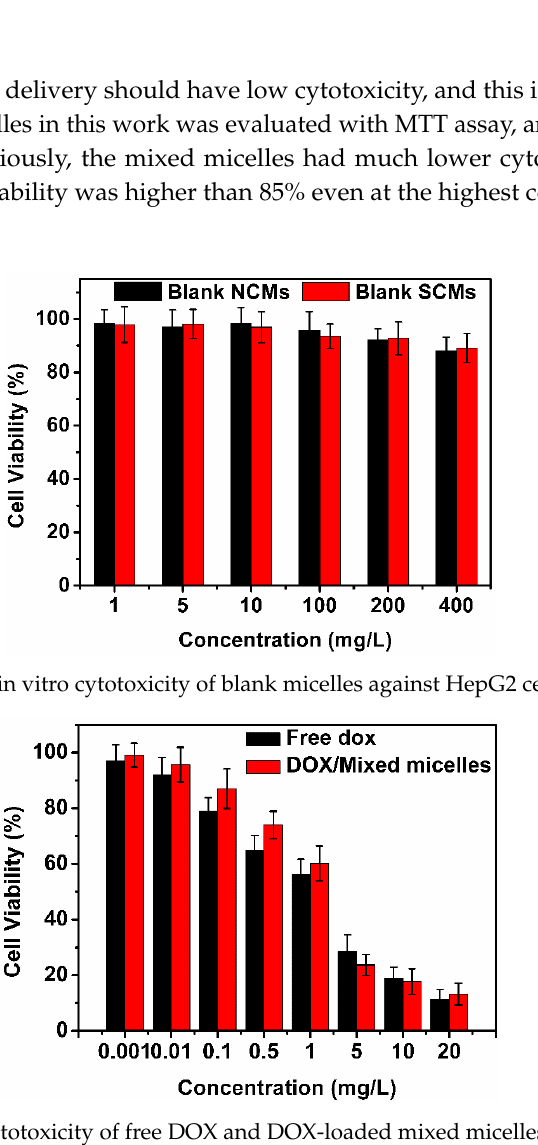
Figure 12. The in vitro cytotoxicity of free DOX and DOX-loaded mixed micelles against HepG2 cells for 48 h. for 48